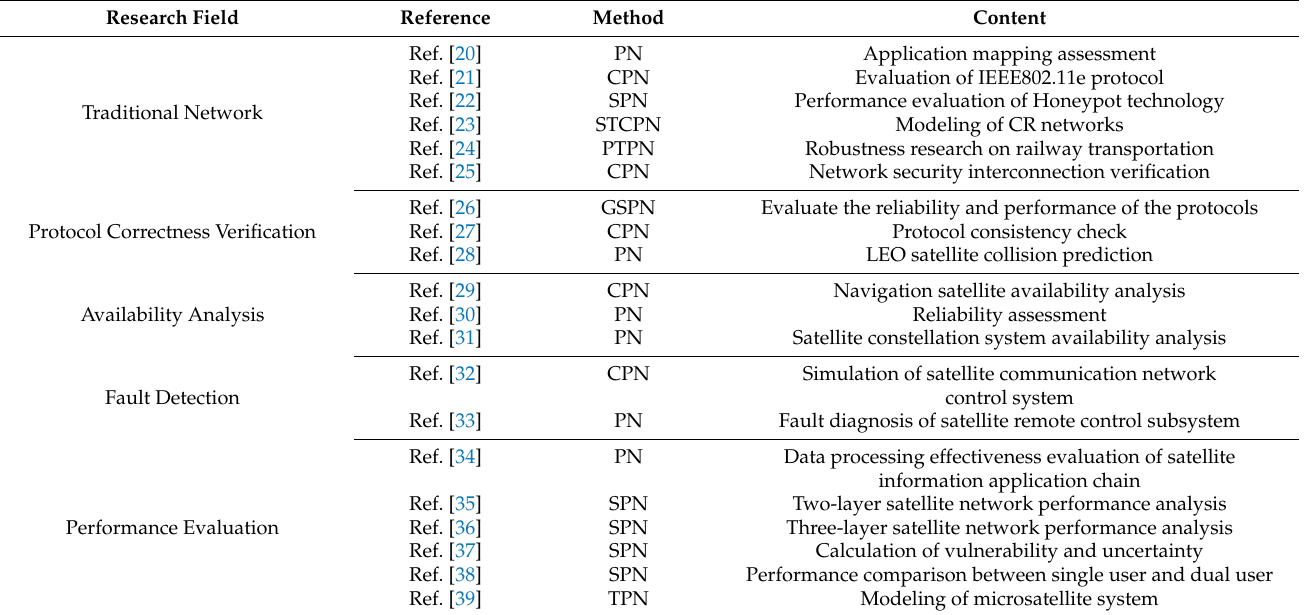
Table 1. Summary of research literature based on Petri